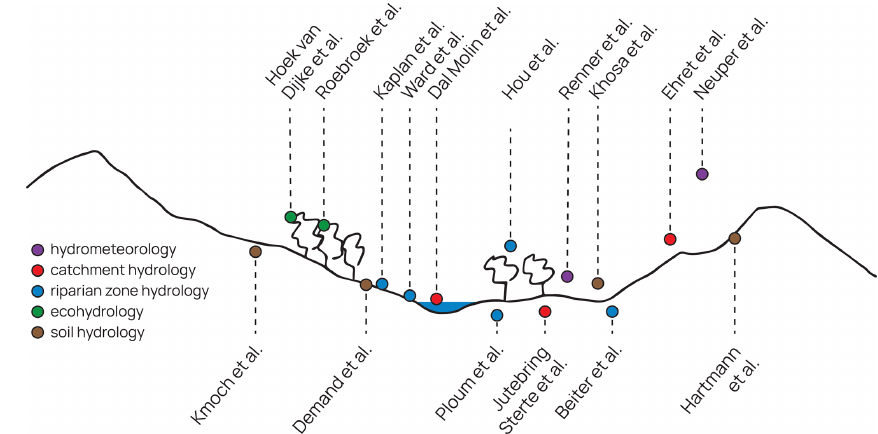
Figure 1. Subdiscipline and landscape elements of the